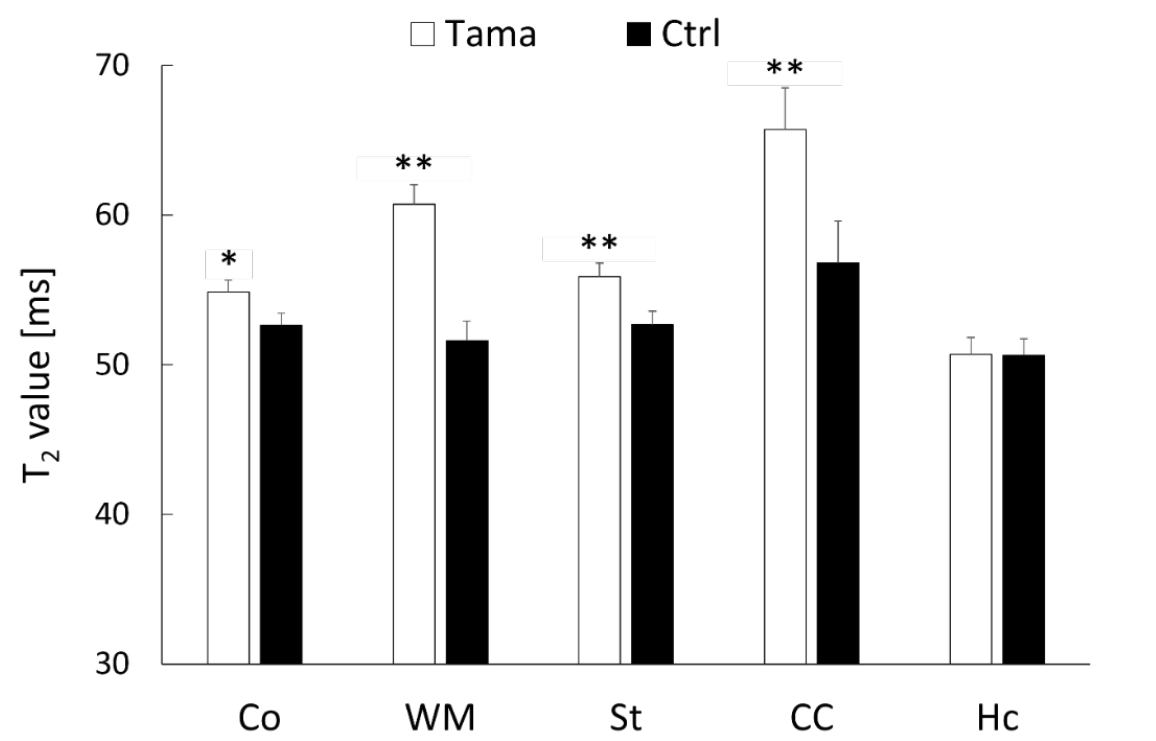
Figure 3. T 2 values in the cerebral cortex (Co), white matter (WM), striatum (St), corpus callosum (CC), and hippocampus (Hc) were measured. The average values of the Tama and control rats (Ctrl) were measured. The values of the Tama rats showed * p < 0.05 and ** p < 0.01 compared with the control rats.